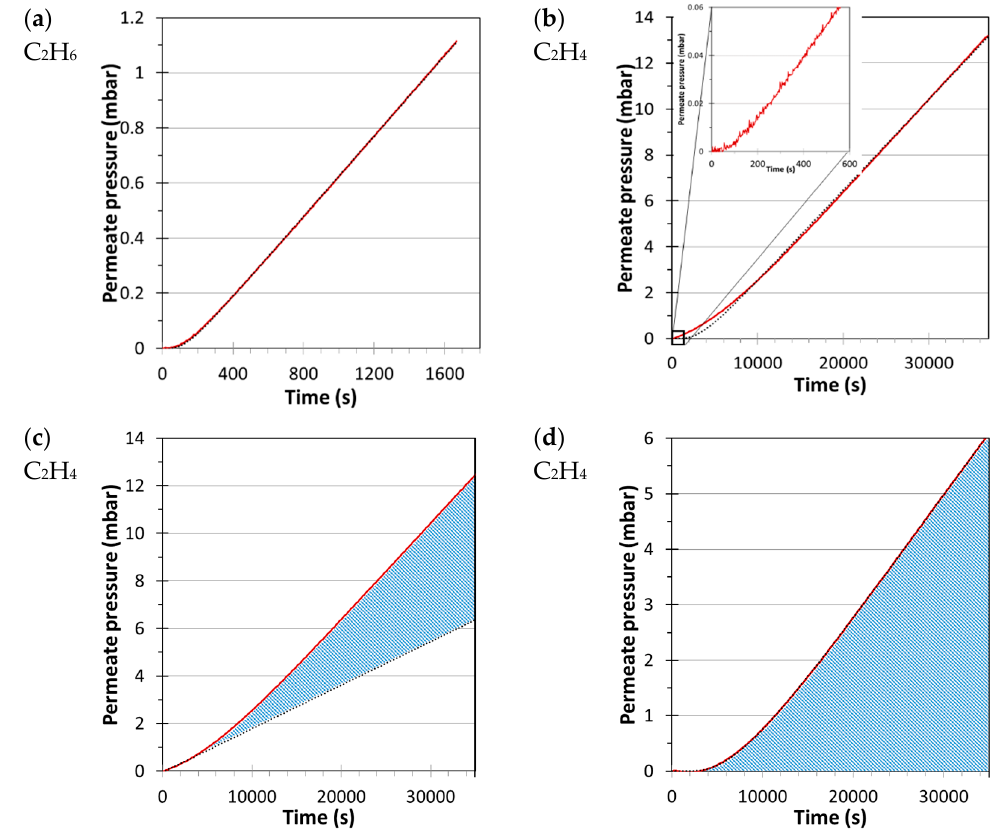
Table 1. Permeability [Barrer], Diffusion coefficient [10 − 12 m 2 s − 1 ] and Solubility [cm 3STP cm − 3 bar − 1 ] of the Pebax ® 1657/Cu II2 (S,S)-hismox mixed matrix membrane at 25 °C and 1 bar of feed pressure determined by the tangent and the fitting methods (double Time Lag).